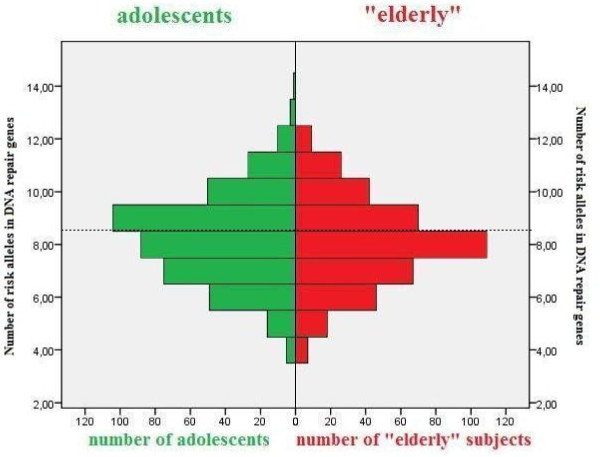
Numbers of risk alleles in DNA repair genes among the adolescents and the 'elderly'. The dashed line represents the cut-off point between the relatively low (≤8) and high (> 8) sum of risk alleles (see methods). The number of persons with nine to fourteen at-risk alleles is smaller among the elderly (p = 0.017). As can be seen from the figure, among the "elderly" the group with 8 at risk alleles counts the most subjects, more then hundred (109), whereas among the adolescents the group with 9 at risk alleles counts the most subjects, more the hundred (104).